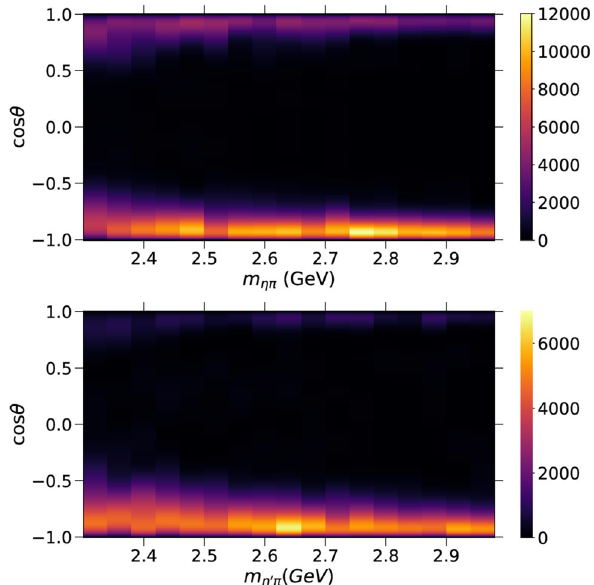
Fig. 3 Intensity I θ ( m , cos θ) density distribution of the MVR from the ηπ (upper) and η (cid:2) π (lower) COMPASS partial